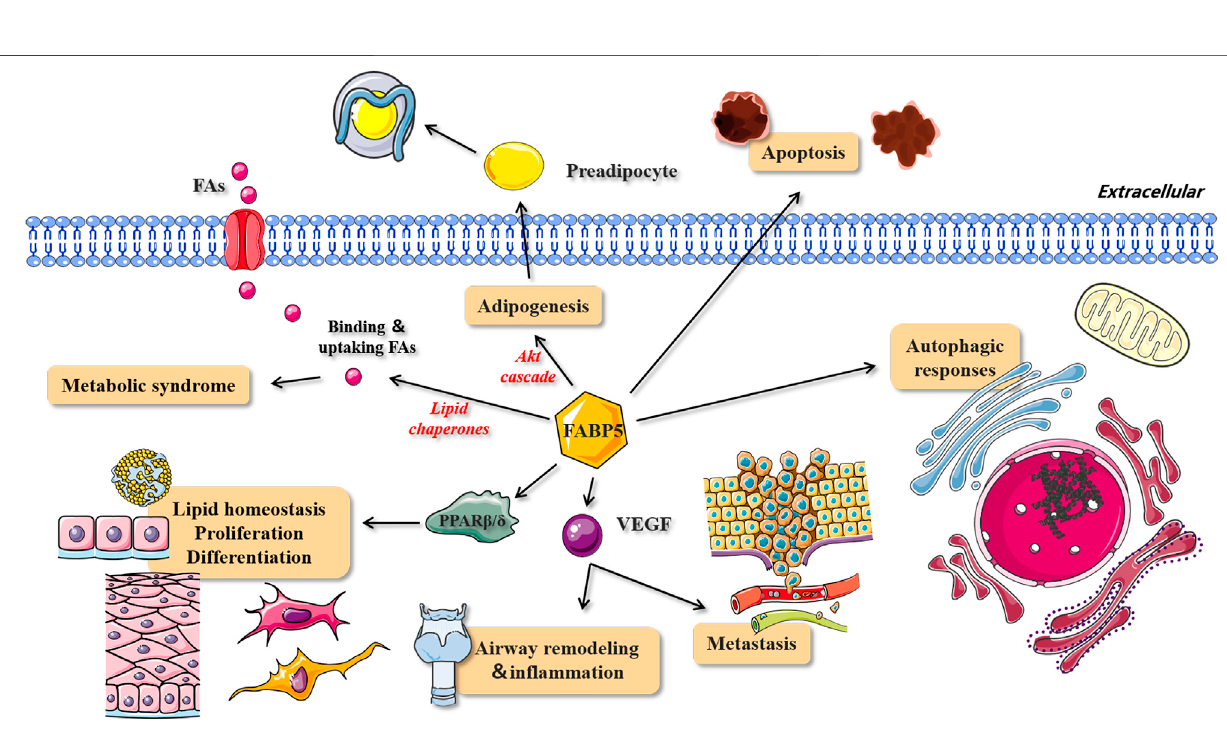
Frontiers in Cell and Developmental Biology |